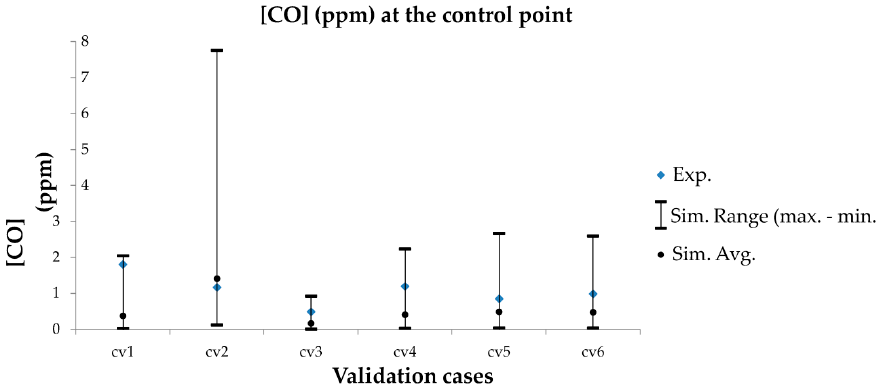
Figure 4. Comparison between experimental CO concentration (ppm) and numerical results at the control point used to validate the model for the six validation